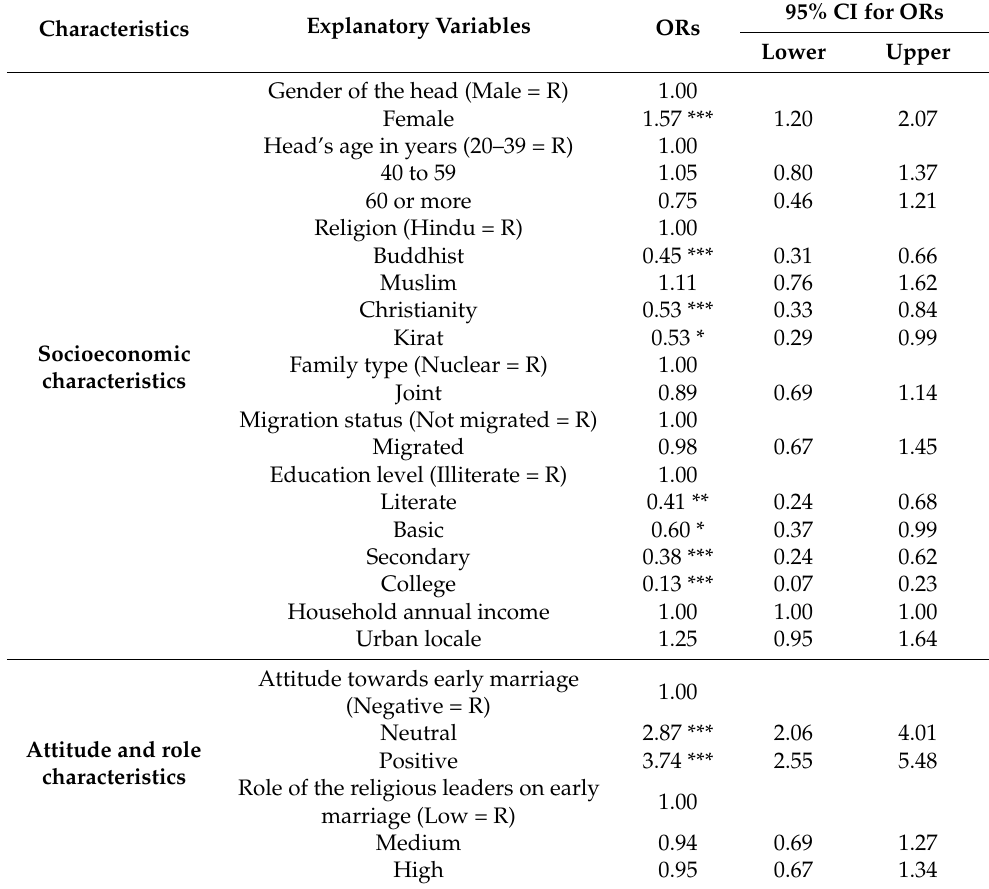
Table 3. Determinants of Early Marriage, Results from Logistic Regression.